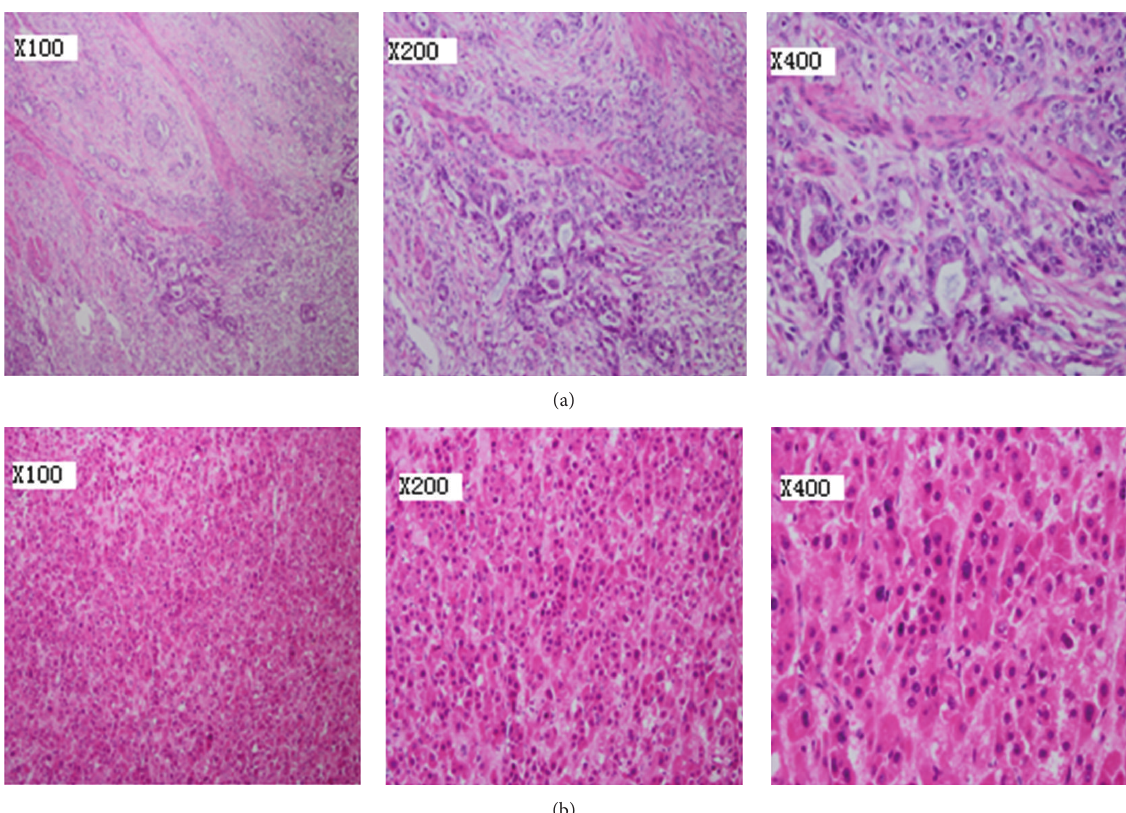
Figure 3: (a) A microscopic examination reveals stomach poorly differentiated adenocarcinoma (hematoxylin and eosin, × 100, × 200, × 400). (b) Primary hepatocellular carcinoma is described by a microscopic examination (hematoxylin and eosin, × 100, × 200, and ×